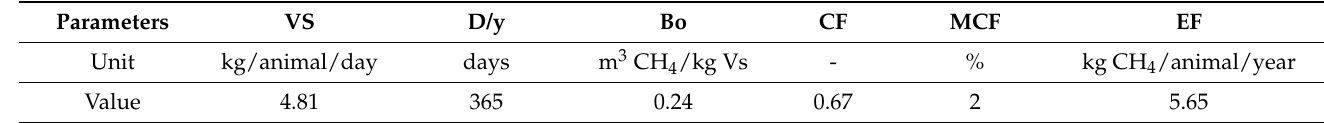
Table 1. Factors used in the calculation of CH 4 emissions from cow manure (source [19]).